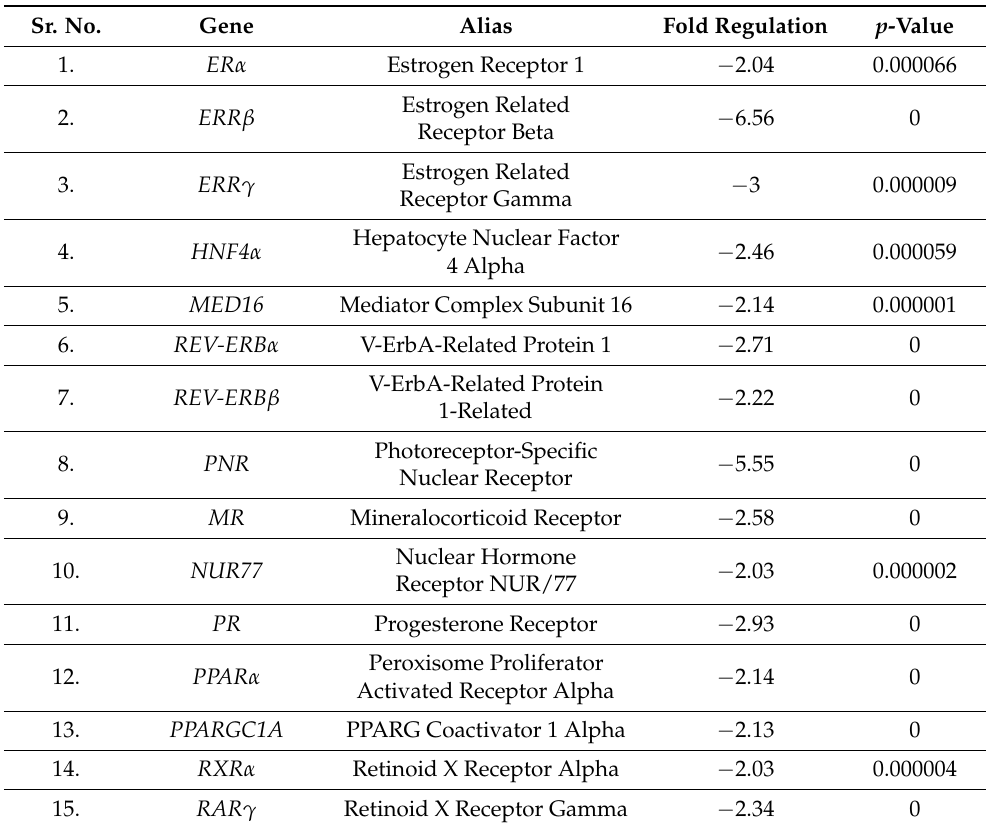
Table 2. List of downregulated genes in choroids of the experimental laser induced CNV mouse model. CECs were isolated from mice subjected to laser injury and control group, not treated with laser. Nuclear receptor and co-regulator expressions were evaluated by PCR arrays. Analyses were performed on the Geneglobe analysis